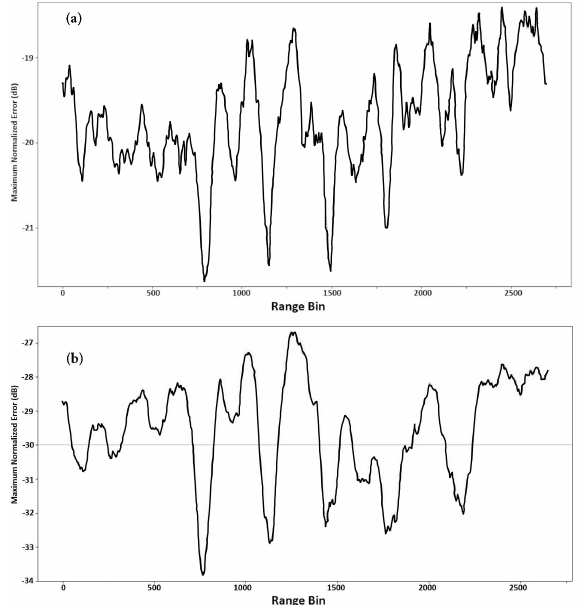
Figure 5. Variation of MNE with respect to the range direction (a) Before Calibration, (b) After Quegan’s